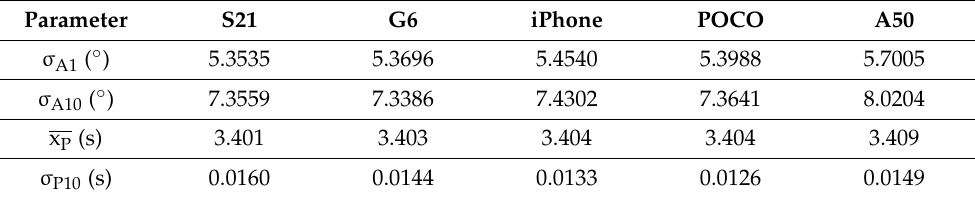
Table 3. Statistical analysis of the orientation data calculated from raw sensor data obtained from smartphones.